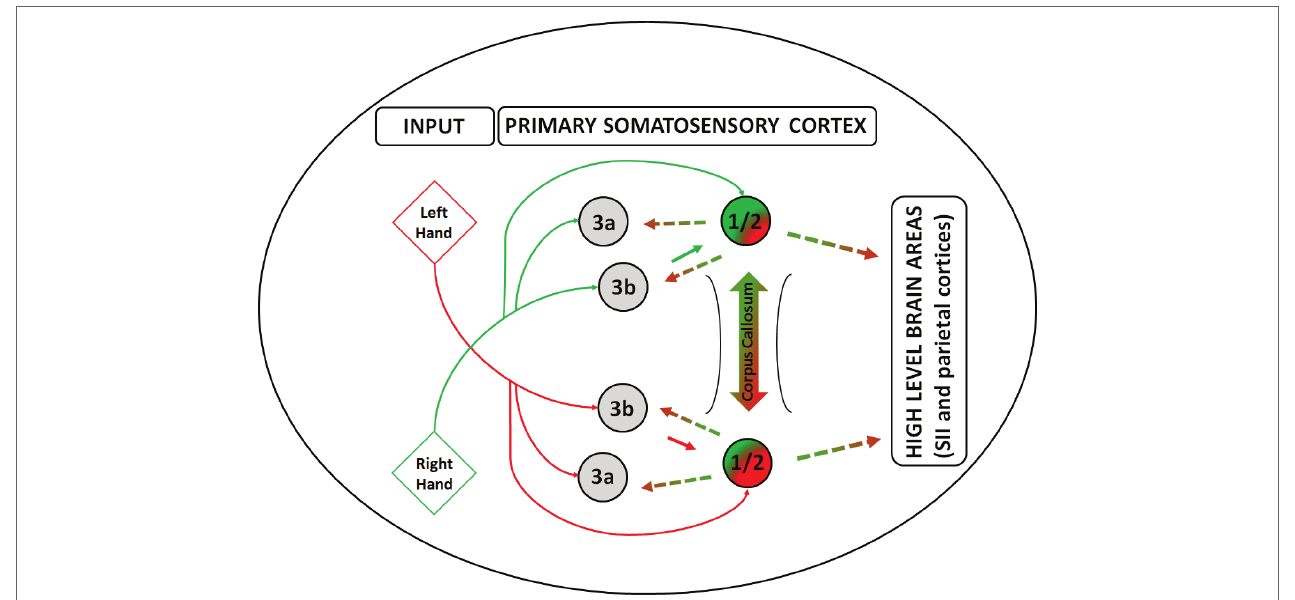
FIGURE 2 | Side integration model. A graphical model of tactile laterality information processing – i.e., Side Integration Model, highlighting the role of areas 1 and 2 in the primary somatosensory cortex in the integration of the lateralized tactile inputs from the two sides of the body. Red lines depict the primarily pathways of information flow coming from the left body side from tactile and proprioceptive afference, whereas green lines depict information coming from the right body side. Gradient line depicts the integration of the inputs from the two sides of the body through the corpus callosum, whereas the dashed lines depict the information flow including the body laterality towards the other areas within the primary somatosensory cortex and beyond. Inputs are depicted as diamond shapes and cortical brain areas as